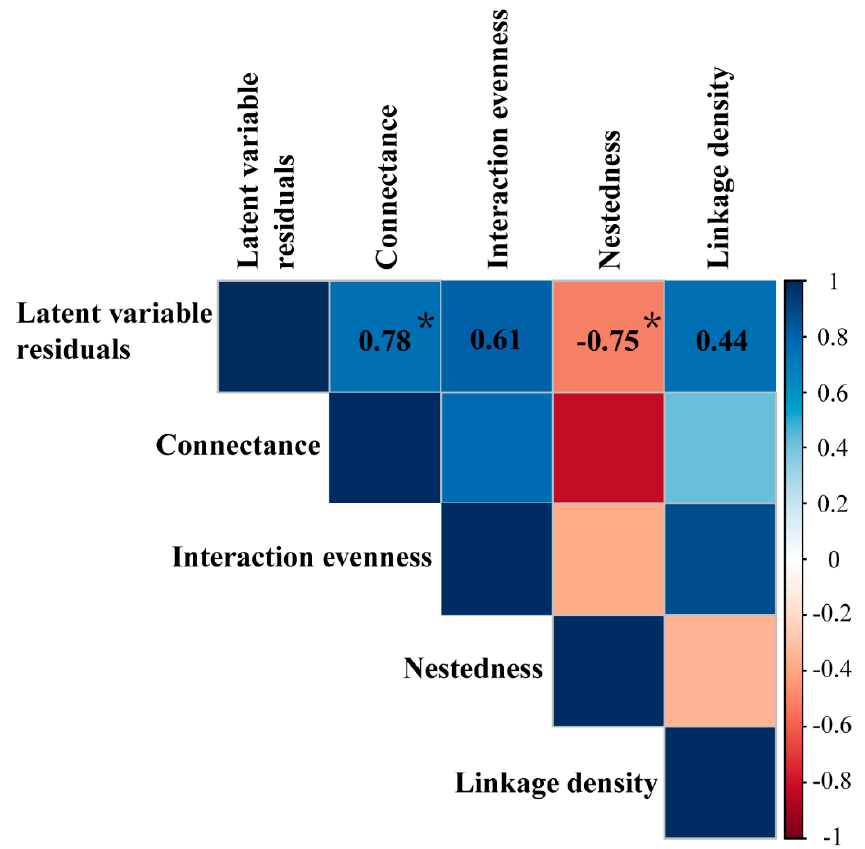
Figure 4. Spearman’s correlations between unexplained residuals underlying imprints of potential species associations (i.e., latent variable residuals) and topology indices of network structures. Positive and negative correlations are shown in blue and red, respectively. Only the correlations of latent variable residuals and topology indices of network structures were shown. Significant results were presented with *.